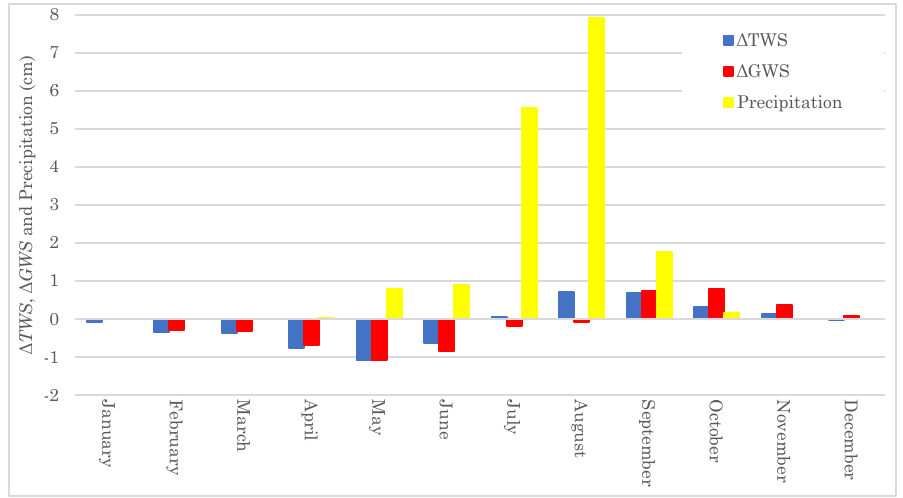
Figure 8. Annual distributions of water storage variations in terms of equivalent water thickness (cm) and precipitation (cm) on the TMB by the means of monthly averages from August 2002 to December 2019.